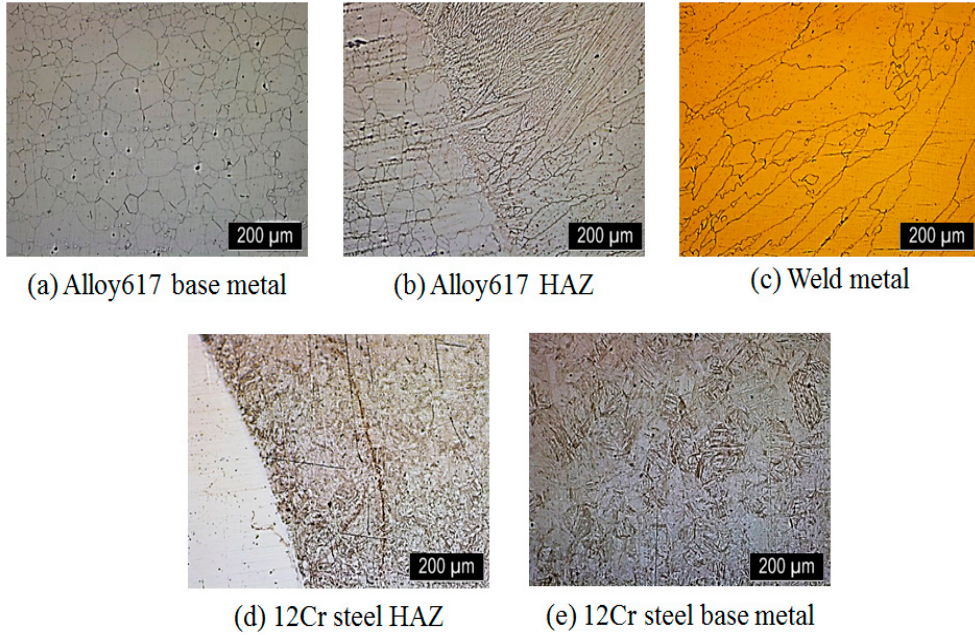
Figure 5. Optical microscope results after PWHT; ( a ) Alloy 617 base metal, ( b ) Alloy 617 HAZ, ( c ) Weld metal, ( d ) 12Cr steel HAZ, and ( e ) 12Cr steel base metal.